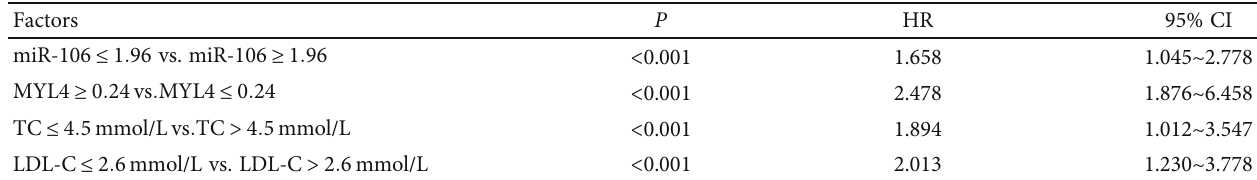
Table 7: Di ff erences between the